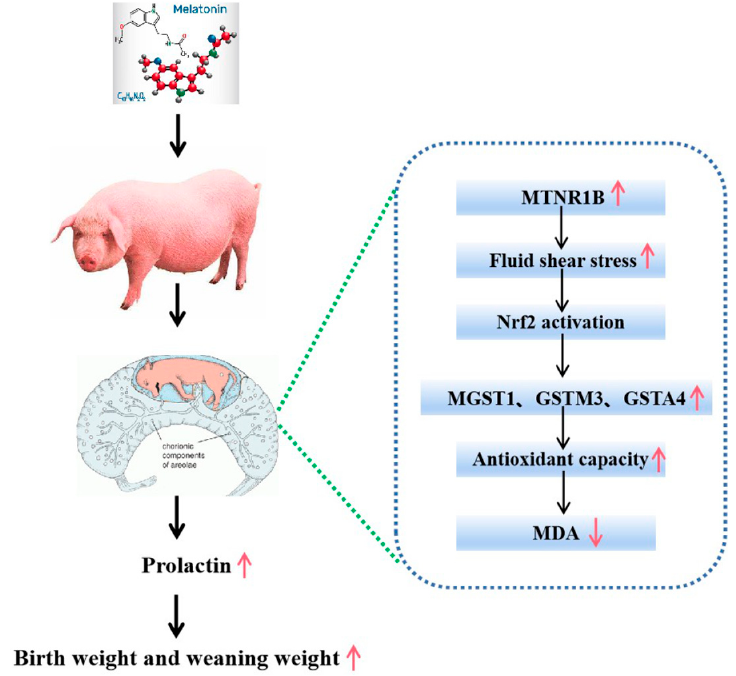
Figure 7. Patterns of increase in birth weight and weaning weight by melatonin supplementation in late gestation of sows (GD 90–GD 114).